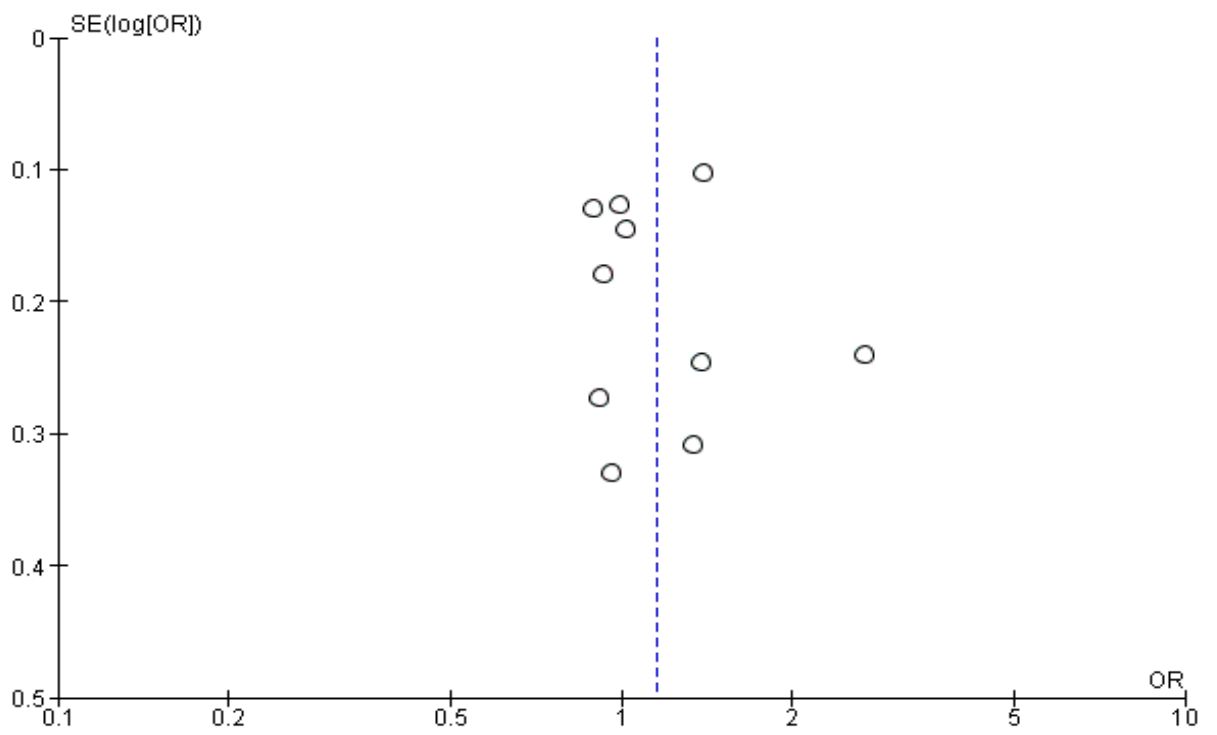
Figure 7. Funnel plot of the studies included in the analysis of the number of accidentally removed parathyroid glands.